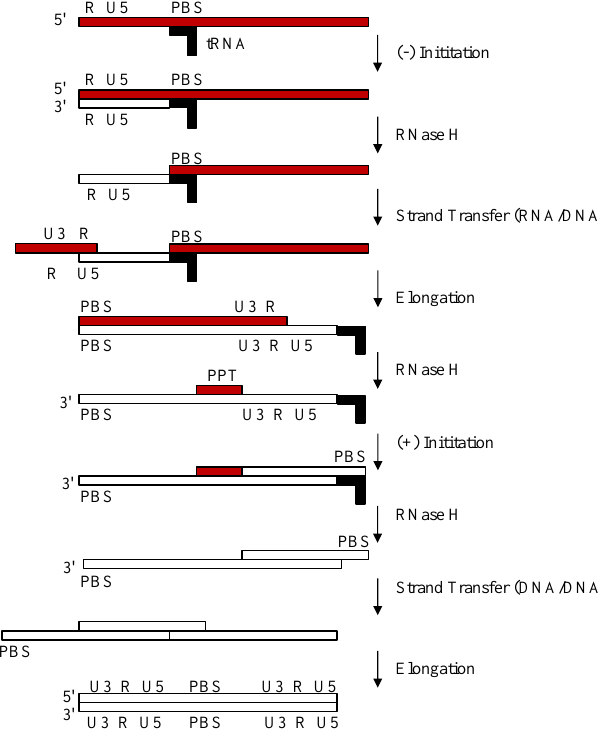
Figure 1. Reverse transcription. Schematic of the multistep process of the conversion of viral RNA (red) into integrase-competent dsDNA (bottom) for insertion into the human genome. PBS, primer binding